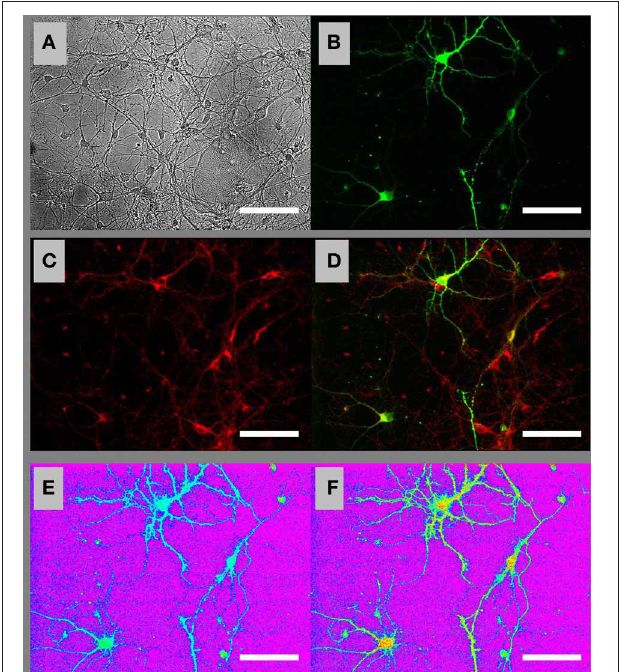
FIGURE 1 | Ratiometric fluorescence imaging of embryonic cultured hippocampal neurons expressing AT1.03 and loaded with a mitochondrial membrane potential sensitive dye TMRM. (A) Bright-field image of cells in the visual field. (B) Fluorescence image of the same field showing AT1.03 at the acceptor wavelength (excitation 500nm, emission 535nm). (C) Fluorescence image of TMRM loaded both in the AT1.03-expressing neurons and in the surrounding non-transfected cells. (D) Overlay of AT1.03 from (B) (green) and TMRM from (C) (red). (E) Ratiometric AT1.03 image under resting conditions. The image was digitally constructed by diving an F436 image (excitation 436nm, emission 535nm) by the nearly-simultaneously acquired F500 image (excitation 500nm, emission 535nm). (F) Ratiometric AT1.03 image under Gluc deprivation conditions. The pseudo-color palette in (E) and (F) has been selected so that purple corresponds to the cell-bearing substrate, blue–green colors correspond to the baseline (high) levels of [ATP]c, and “warmer” colors (yellow–red) correspond to progressive depletion of [ATP]c. Scale bars: 50 μ